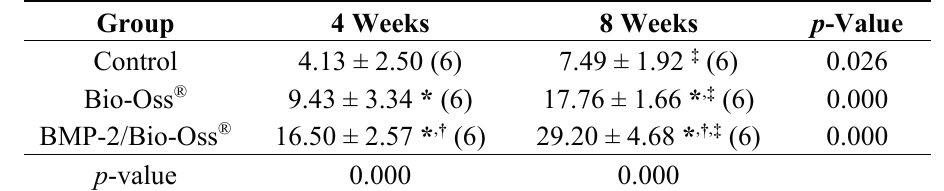
Table 4. Amounts of new bone as percentages of augmented areas at four and eight weeks after surgery (means ± SD (number of